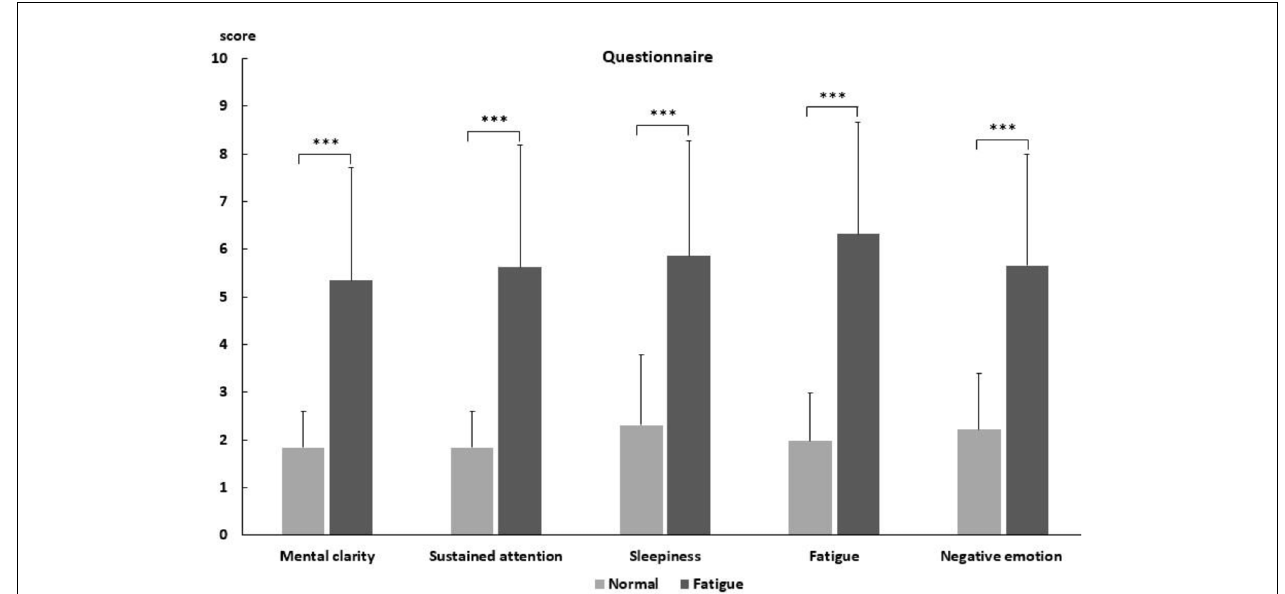
FIGURE 2 | The questionnaire results for normal and fatigued state. ∗∗∗ Difference is significant at the 0.01 level.